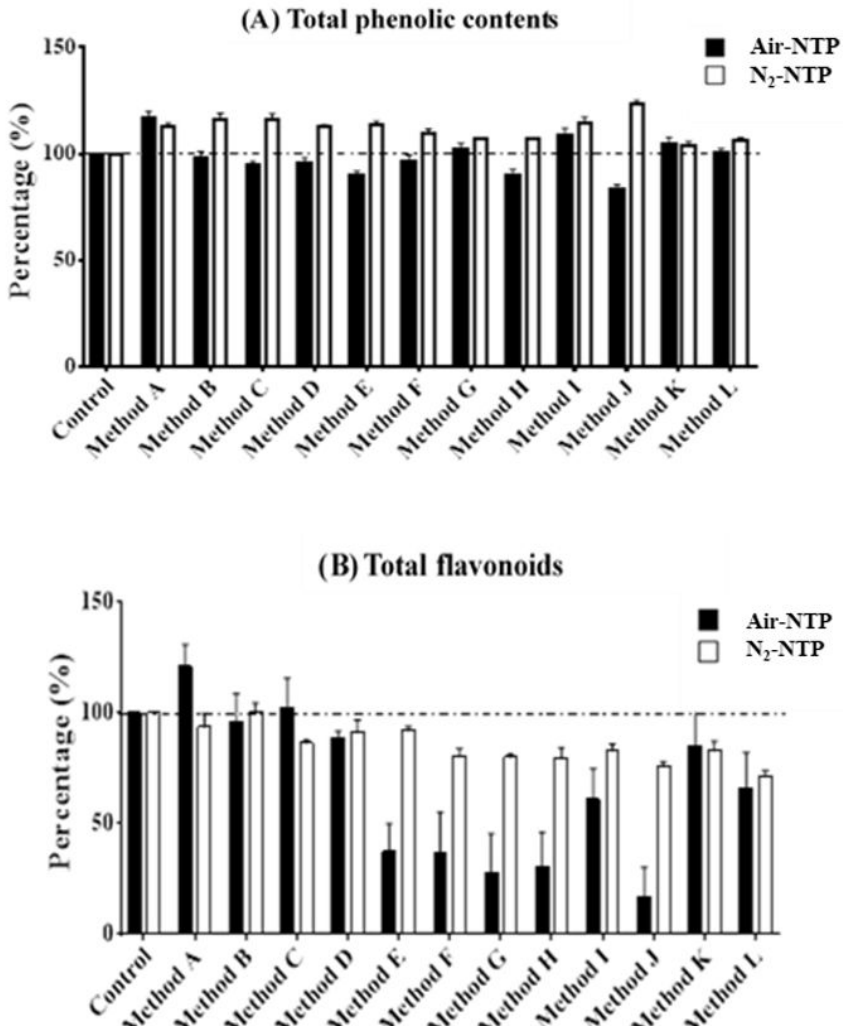
Figure 4. Levels of phenolic acids and flavonoids in the NTP-treated and untreated djulis seeds shown as total phenolic content in the NTP-treated seeds compared with the untreated control: ( A ) flavonoids in NTP-treated seeds compared with the untreated seeds (control) and ( B ) levels of gallic acid and rutin in seeds before and after NTP